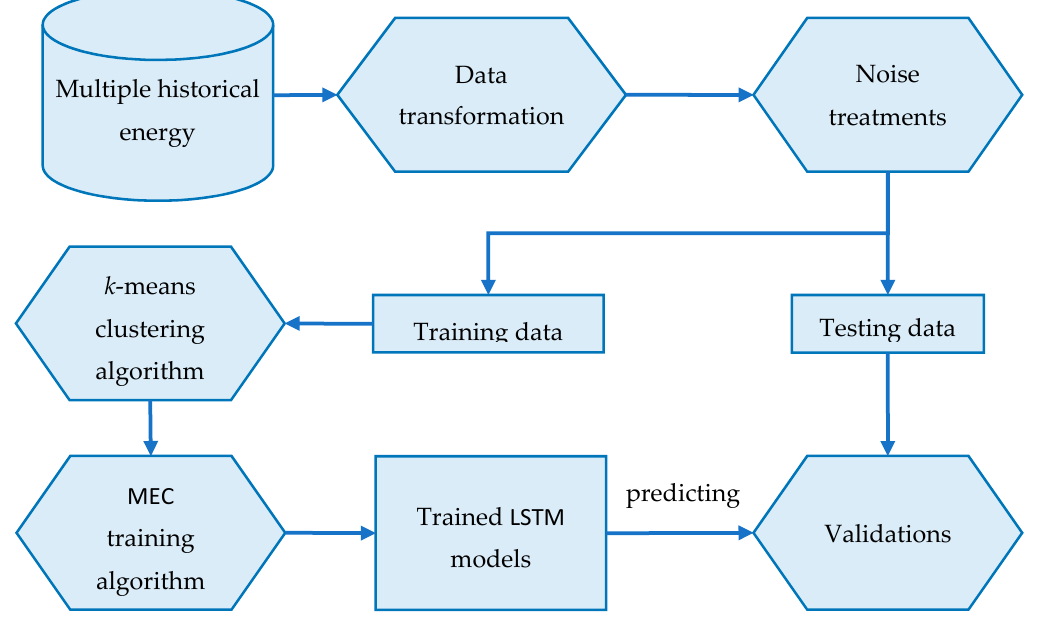
Figure 6. The overall architecture of the MEC-TLL framework.